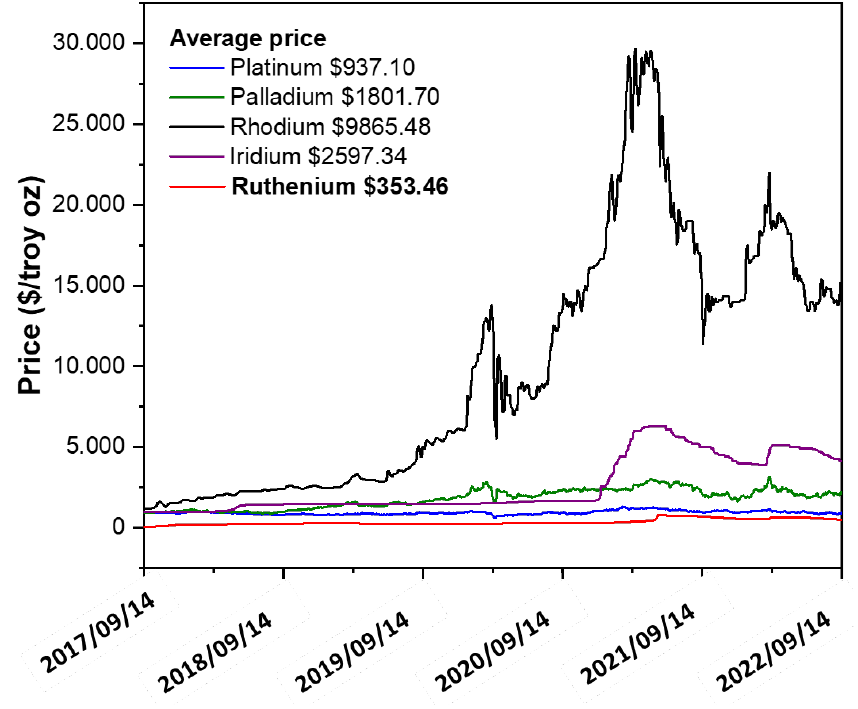
Figure 1. Flow chart of PGMs prices over the last five years. Reprinted with permission from [7].